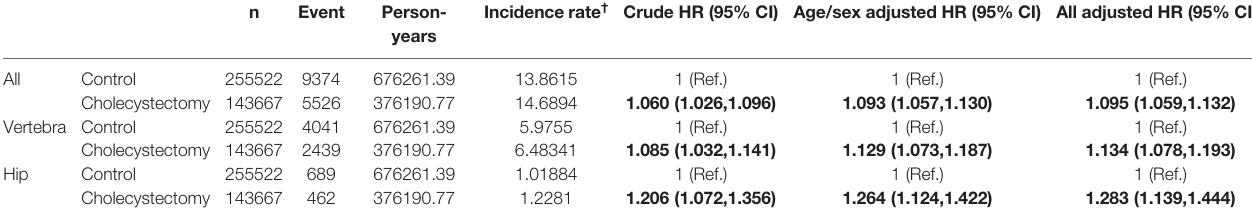
TABLE 2 | Incidence of fractures in cholecystectomy group and control group. n